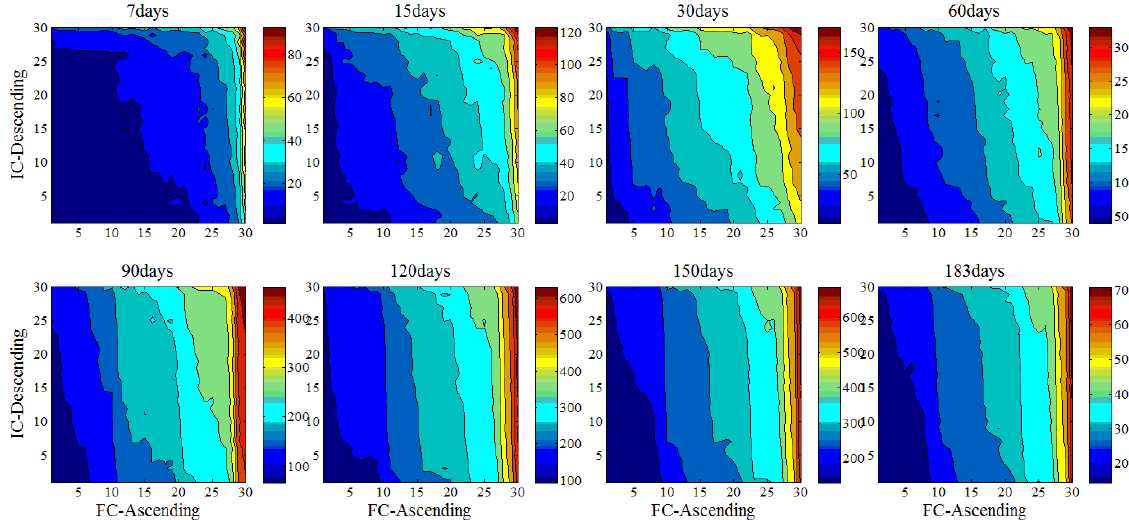
Fig. 7. The same as Fig. 6 but the forecasts are initialized on 1 July.